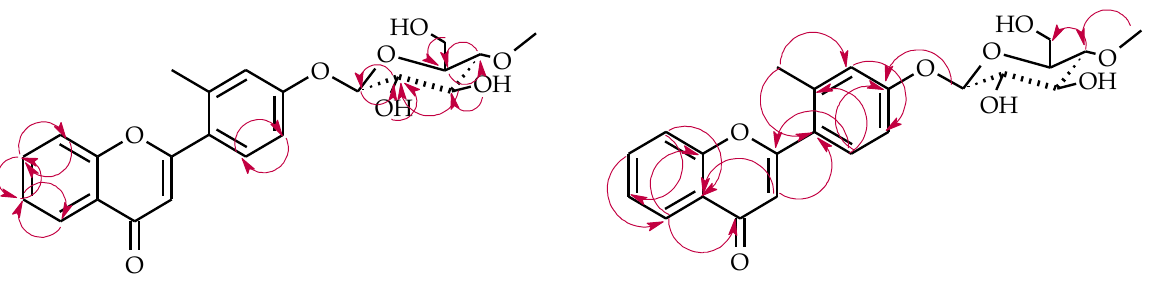
Scheme 11. Key COSY (on the left) and HMBC (on the right) correlations for the structure elucidation of product 5b . In the case of 5c , analysis of NMR spectra revealed that the resulting compound has a 4 ″ -methyl-glucosyl moiety attached at C-5 ′ . The 1 H NMR spectra revealed that protons from A ring remained intact, but protons from the B ring at C-6 ′ , C-3 ′ , and C-4 ′ became shifted and coupling constants between them pointed that substitution occurred at C-5 ′ (Supplementary Materials: Figure S154). Glycosylation at C-5 ′ was confirmed in the HMBC experiment by coupling between the proton at the anomeric carbon atom (δ = 5.02 ppm) with the C-5 ′ signal (δ = 156.9 ppm), which was shifted from δ = 127.1 ppm, indicat- ing the attachment of an electronegative atom (Supplementary Materials: Figure S167). Furthermore, in the HMBC experiment the signal from proton at C-6 ′ (δ = 7.35 ppm) was coupled with C-4 ′ (δ = 119.9 ppm) and C -2 ′ ( δ = 131.0 ppm), signal from proton at C-3 ′ (δ = 7.31 ppm) was coupled with C-1 ′ ( δ = 134.3 ppm) and shifted C-5 ′ ( δ = 156.9 ppm) (Sup- plementary Materials: Figure S166) (Scheme 12). O O